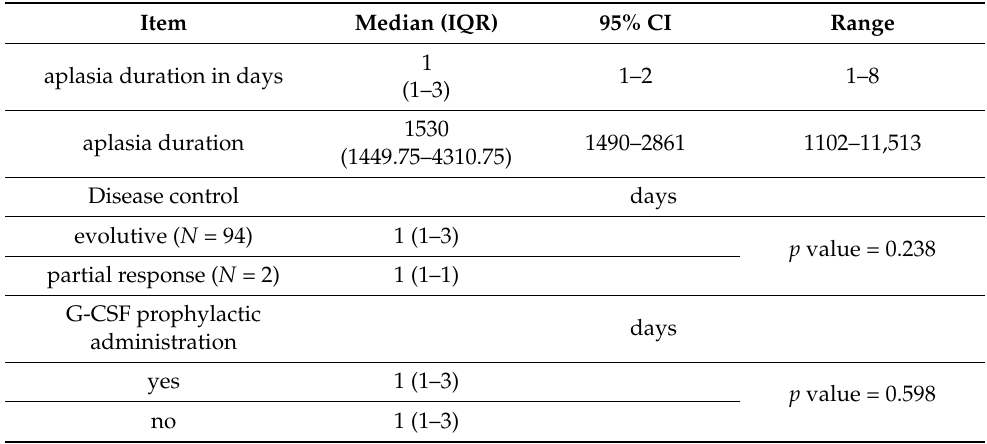
Table 2. Median duration of FN